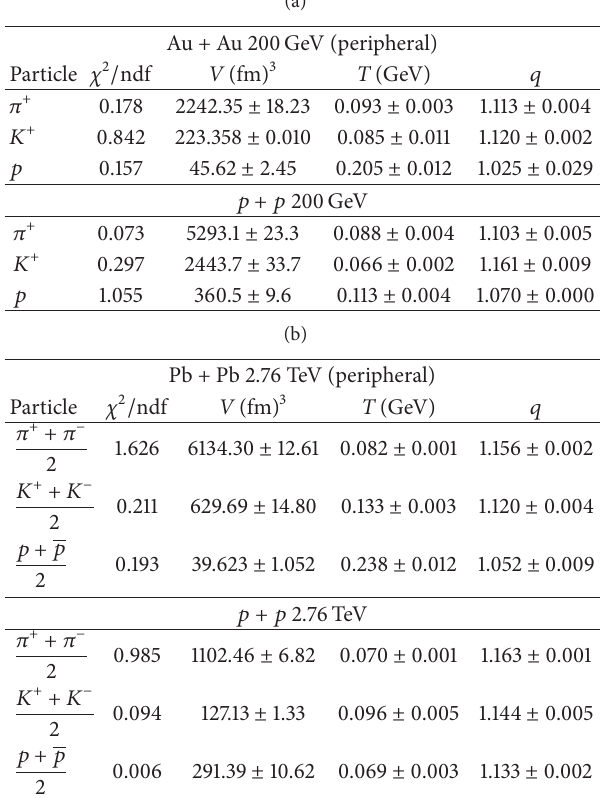
Table 1: 𝜒 2 / ndf and different extracted parameters from Tsallis distribution fit (see (7)) to the 𝑝 𝑇 spectra of (a) 𝜋 + , 𝐾 + , and 𝑝 for most peripheral Au + Au collisions and 𝑝 + 𝑝 collisions at √𝑠 NN = 200 GeV; (b) (𝜋 + + 𝜋 − )/2 , (𝐾 + + 𝐾 − )/2 , and (𝑝 + 𝑝)/2 for most peripheral Pb + Pb collisions and (𝜋 + + 𝜋 − )/2 , (𝐾 + + 𝐾 − )/2 and (𝑝 + 𝑝)/2 for 𝑝 + 𝑝 collisions at √𝑠 NN = 2.76